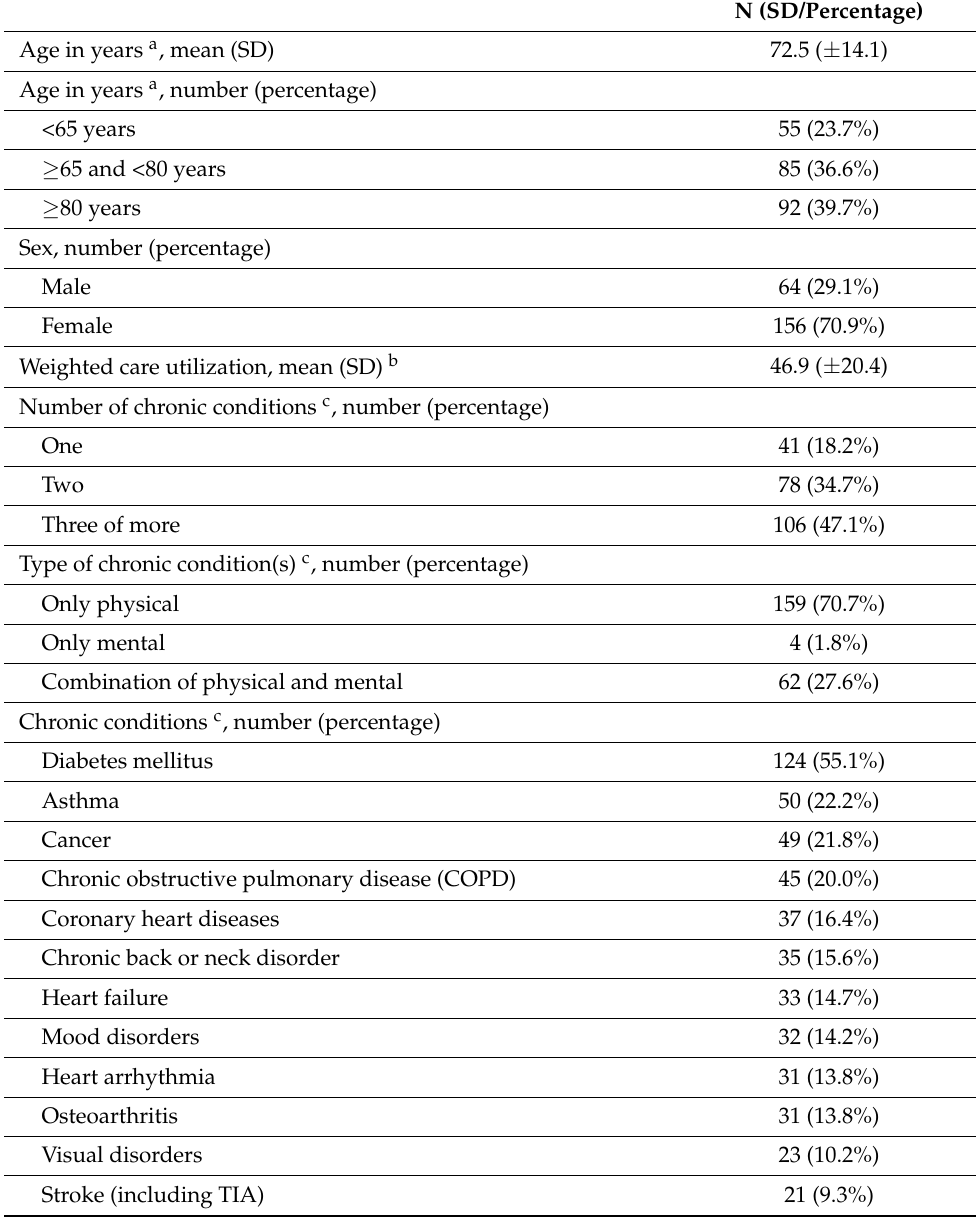
Table 1. Background characteristics of study participants ( n =